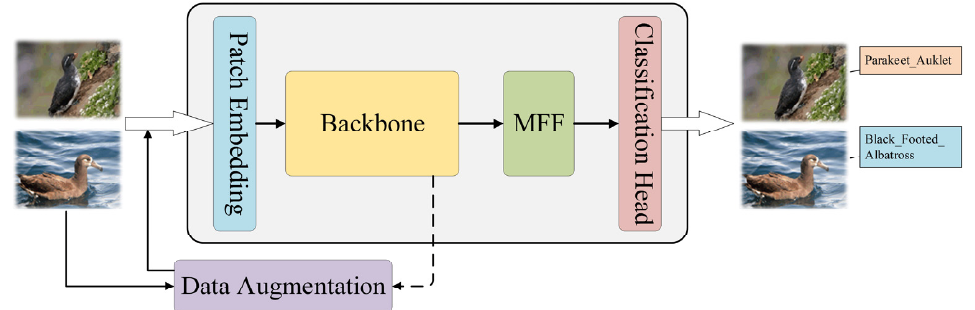
Figure 1. Algorithm framework.